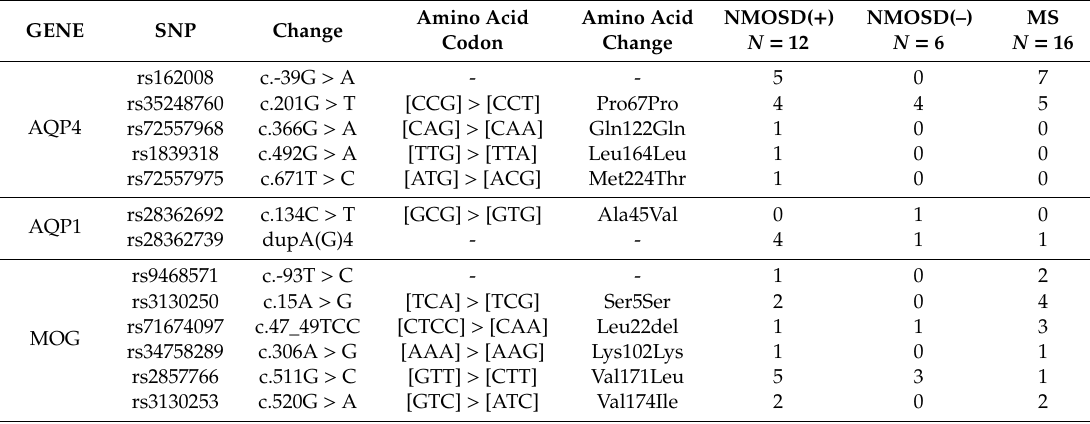
Table 2. Genetic variants in AQP1, AQP4 and MOG genes observed in NMODS( + )